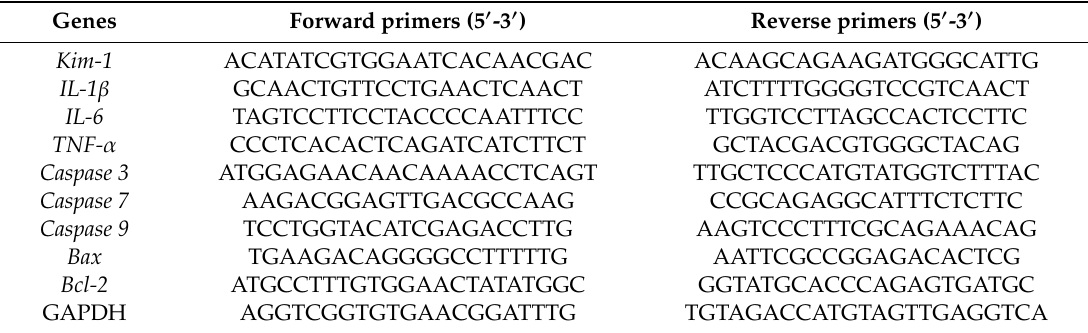
Table 1. Primer sequences used for quantitative real-time PCR